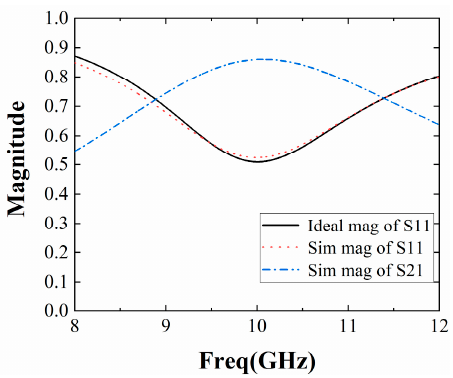
Figure 10. Amplitude of reflection coefficient and transmission coefficient.